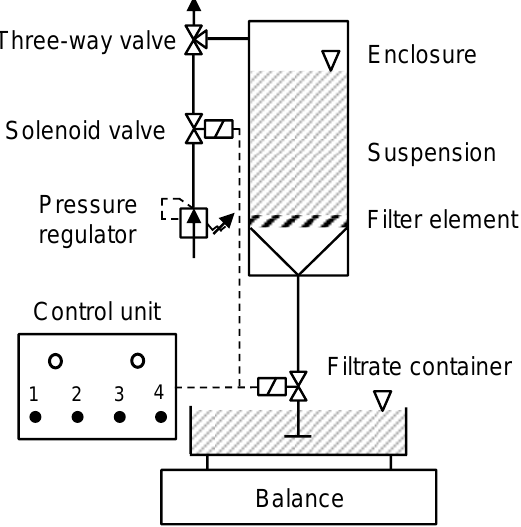
Figure 6. Modified pressurized housing cell.